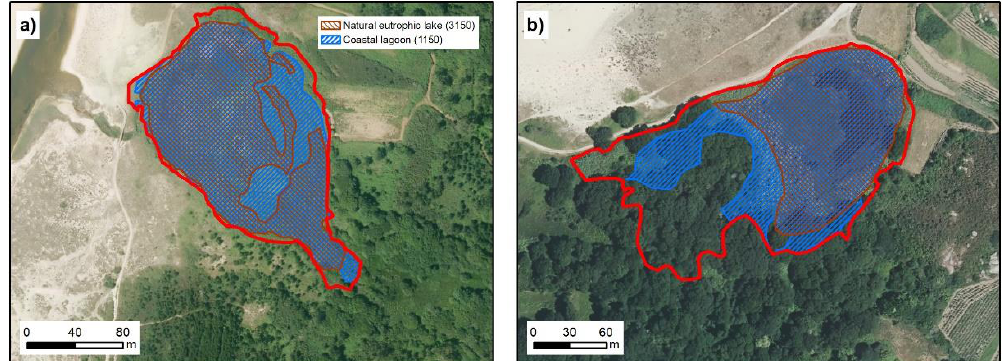
Figure 9. ( a ) represent lake of Xuño and ( b ) represent lake of Bodeira. In both cases it shows the surface occupied by coastal lagoon habitat (blue), and natural eutrophic lake habitat (brown). The red line in all cases represent the extent marked for the lagoon by our analysis (IGN [20]; Xunta de Galicia ©